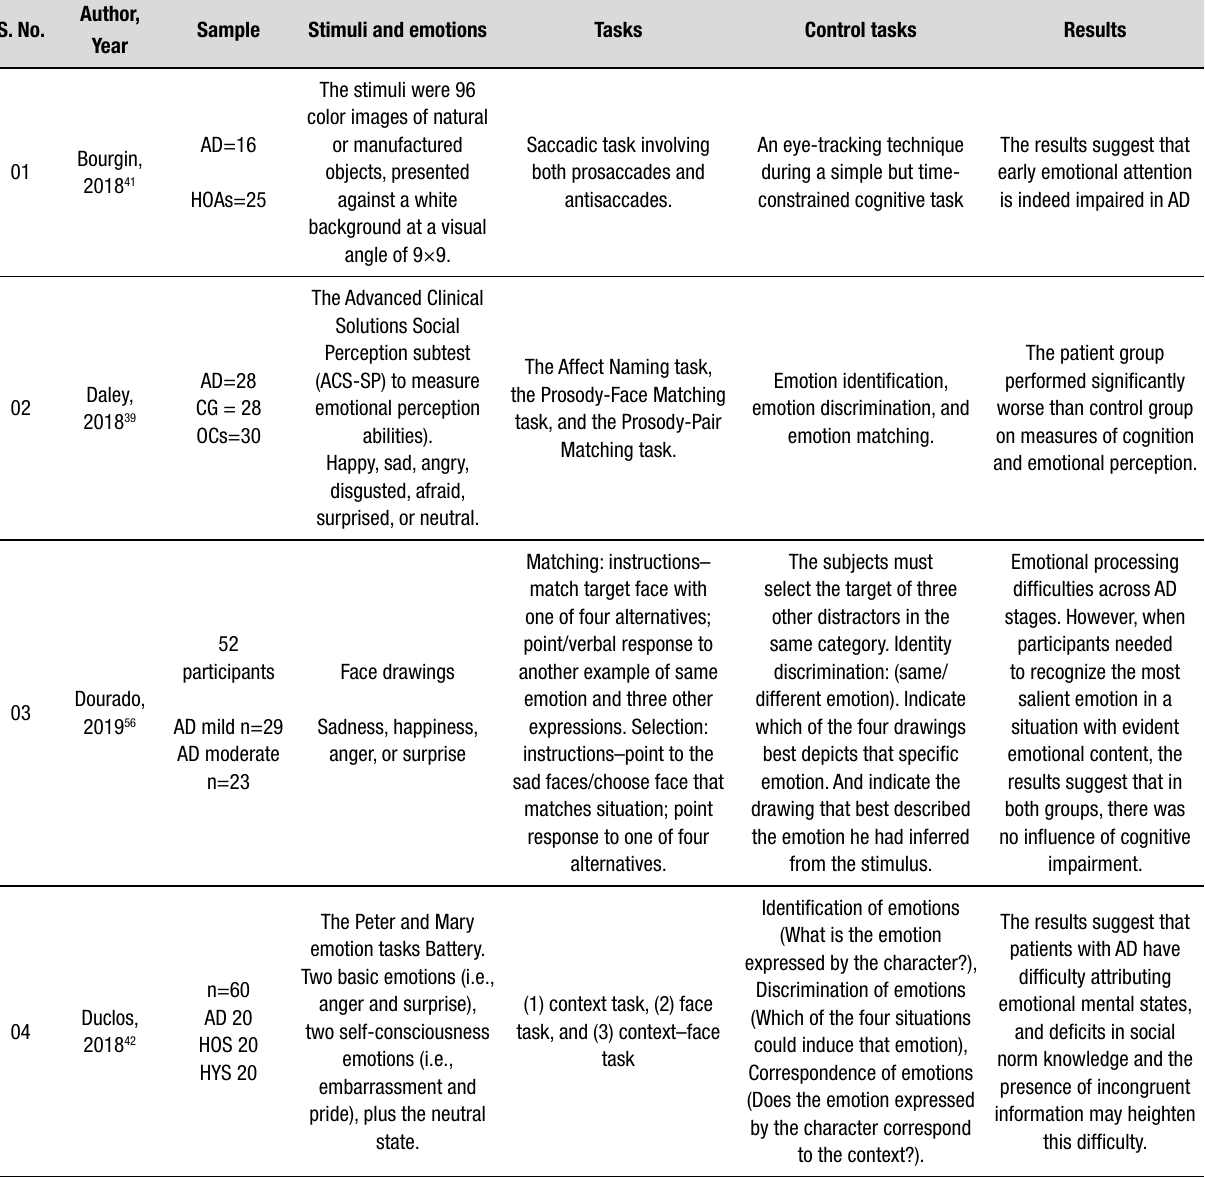
Table 2. Tasks and stimuli for the evaluation of emotion processing. S.